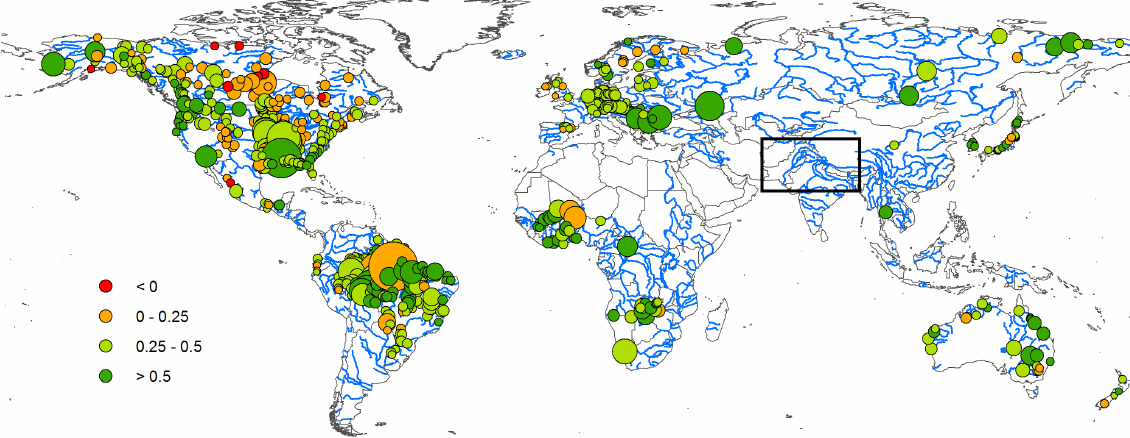
Fig. 6. Peirce’s skill score of simulated versus observed discharge for the 620 stations considered. Circle size is proportional to the upstream area of the river station. The black-contoured rectangle indicates the area shown in Fig. 10.